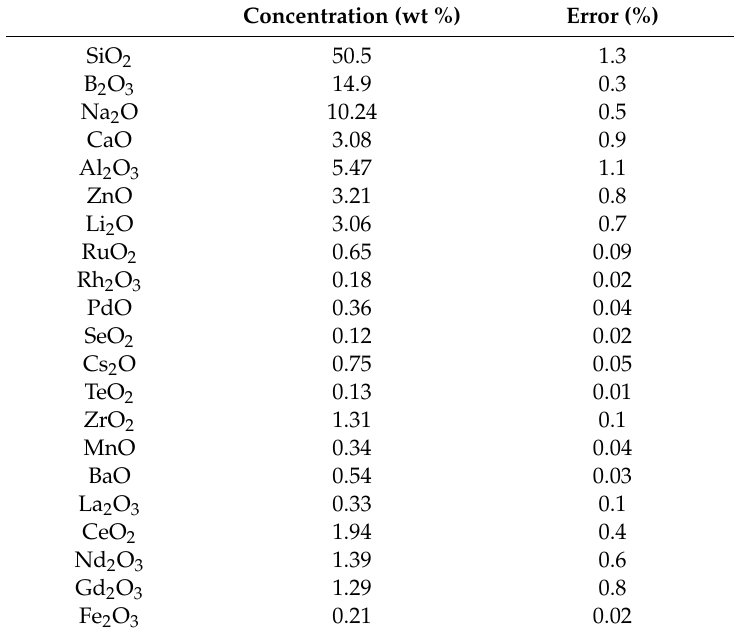
Table 1. Chemical compositions of the simulated high-level vitrified wastes (HLVW). Concentration (wt %) Error (%) SiO